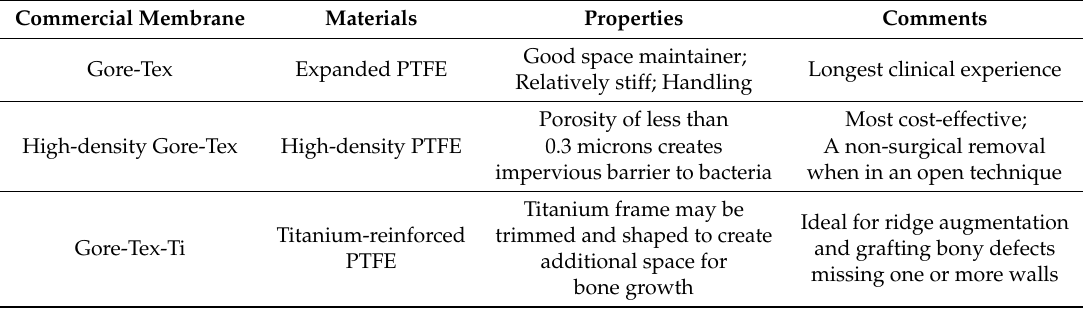
Table 1. The most commonly used commercially available non-resorbable polymeric